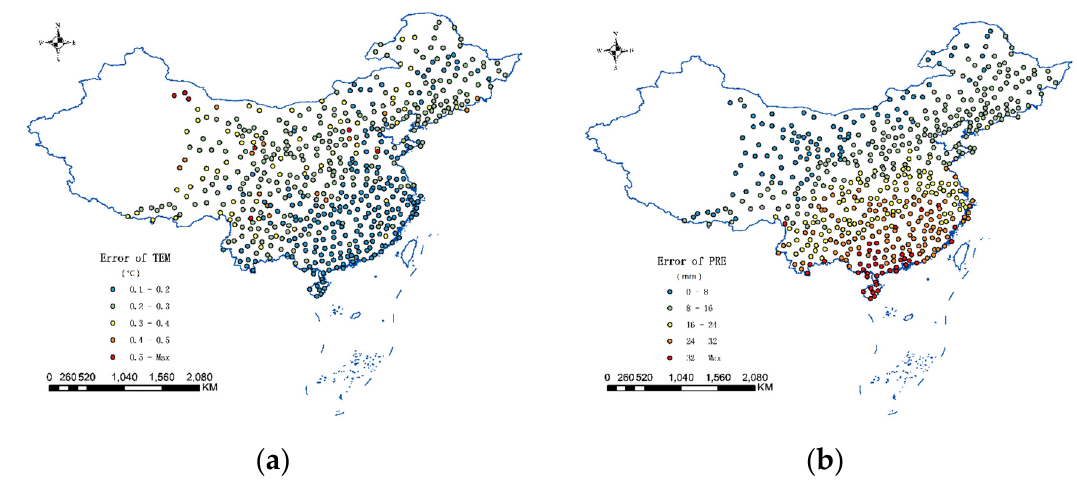
Figure 8. Station srror of the STHC method: ( a ) temperature data; and ( b ) precipitation data.